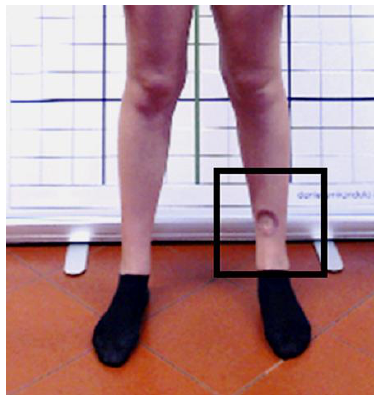
Figure 1. Post-surgical scarring at the left anterior tibia after melanoma resection (black squared